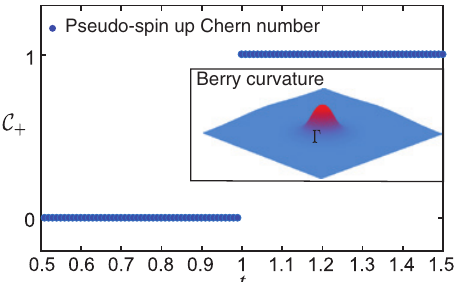
associated with the pseudo-spin +